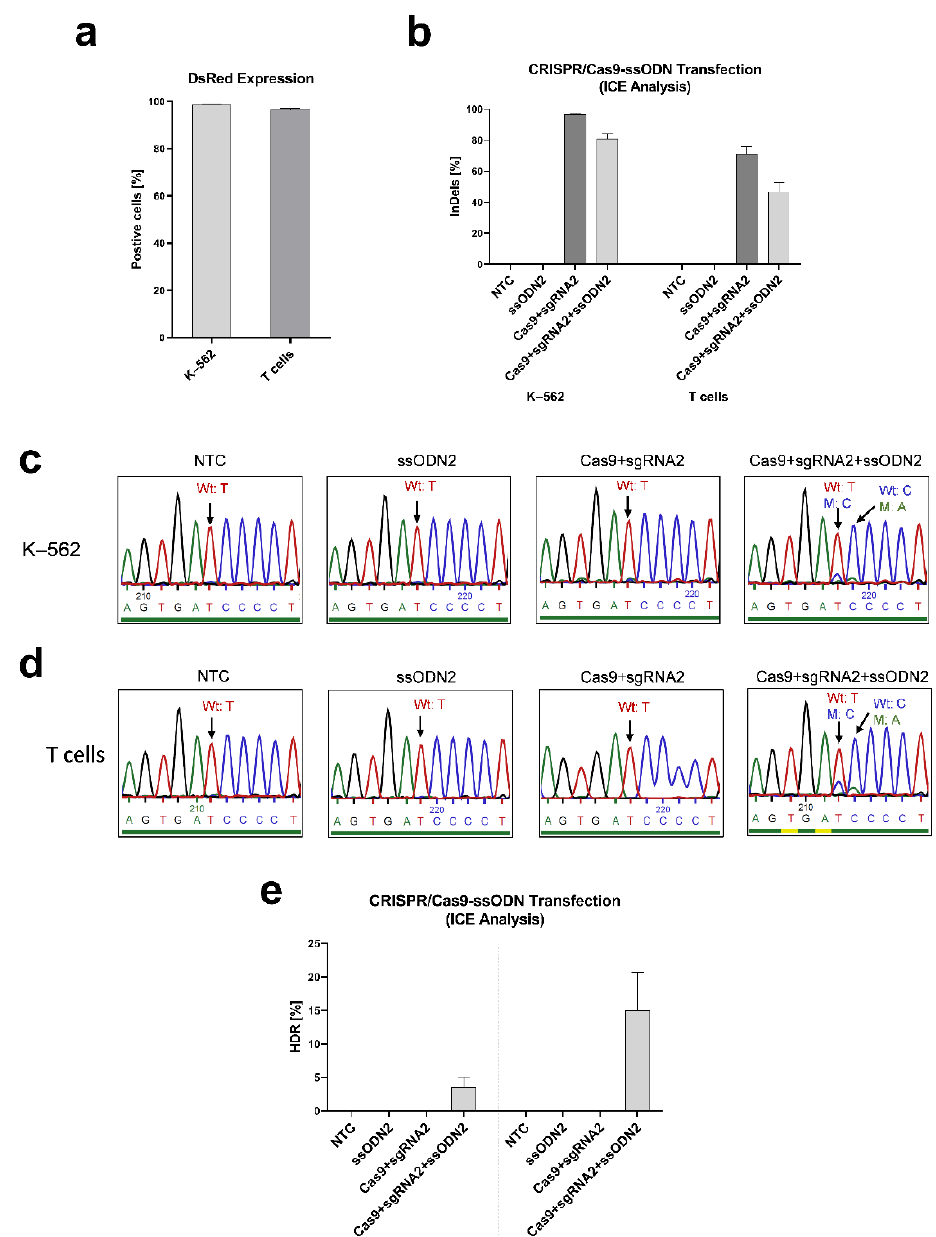
Figure 3. CRISPR/Cas9-ssODN transfection to induce mutation in K – 562 cells and T cells from healthy donors. The transfection of RNP ( IL2RG sgRNA2 and Cas9)-ssODN2 to induce IL2RG mutation in the K – 562 cells (n = 2) and T cells of healthy donors (n = 3) was performed with MaxCyte ® . ( a ) DsRed was expressed in more than 96% of K – 562 cell and T cell control samples. ( b ) The indel frequencies were 96 – 97% (RNP transfection) and 78 – 84% (RNP-ssODN transfection) in K – 562 cells and 66 – 80% (RNP transfection) and 35 – 54% (RNP-ssODN transfection) in T cells. Sanger sequencing results of ( c ) K – 562 cells and ( d ) T cells transfected with RNP-ssODN showed induced mutant nucleotides of c.458C (targeting inducing mutant base) and c.459A (silent blocking mutation) (the blue, red, green, and black peaks stand in place of bases C, T, A, and G respectively). ( e ) HDR efficiency quantified by ICE analysis based on Sanger sequencing showed 3.5 ± 1.5% HDR in K – 562 cells and 15.0 ± 5.7% HDR in T cells. Mean ± SEM of biologically independent experiments is shown.